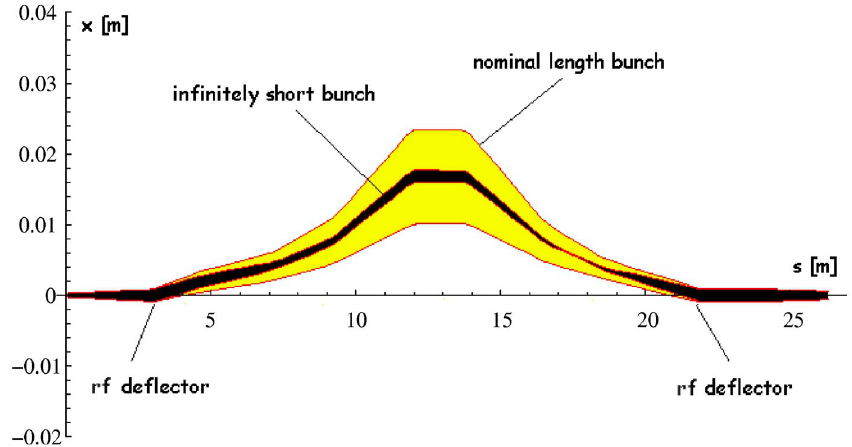
FIG. 5. (Color) Simulated beam envelopes of the bunches of Fig. 4 in the case of an infinitely short bunch and of a bunch length of 3 ps rms. Both bunches have a normalized rms emittance of 15 (cid:12) mm mrad and are located at 2 (cid:12)= 5 on the rf deflecting